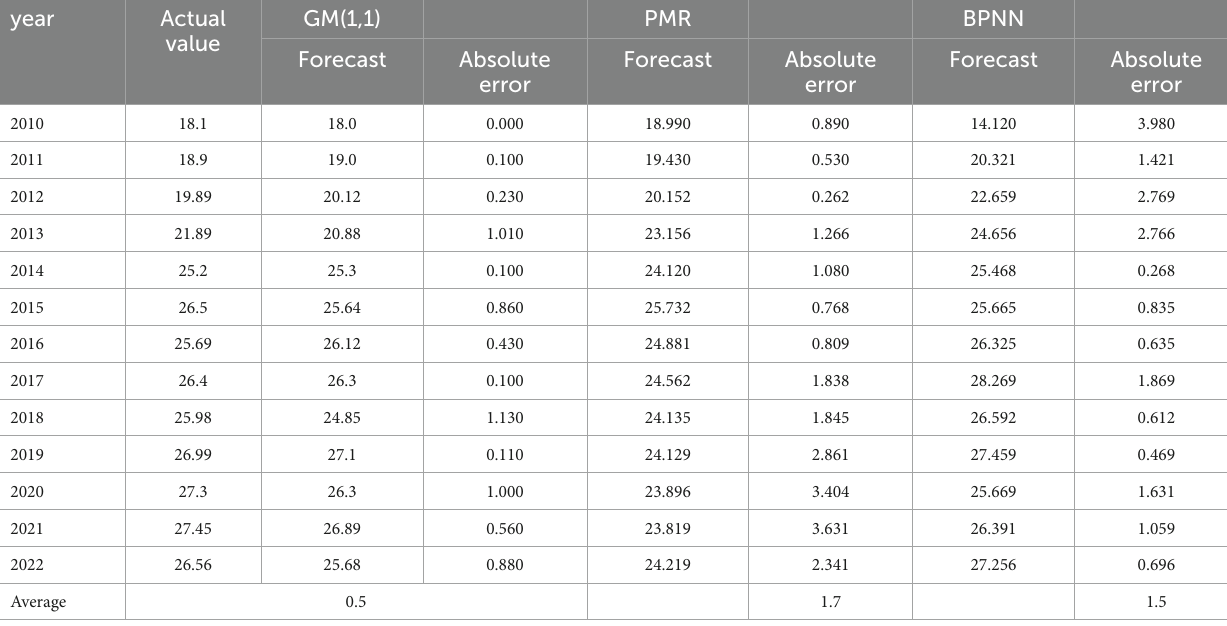
TABLE 4 Comparison between the predicted value and absolute error of a single prediction